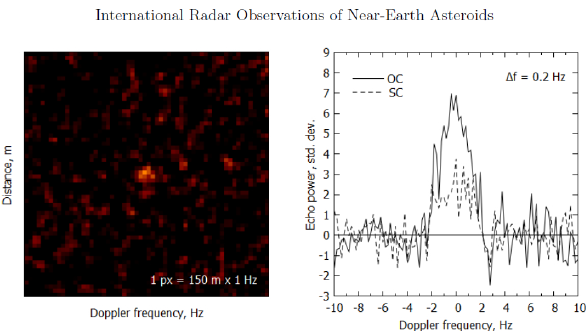
Figure 8. International Radar Observations of Near-Earth Asteroids on Radio Telescopes of the Quasar VLBI Network (Bondarenko et al.